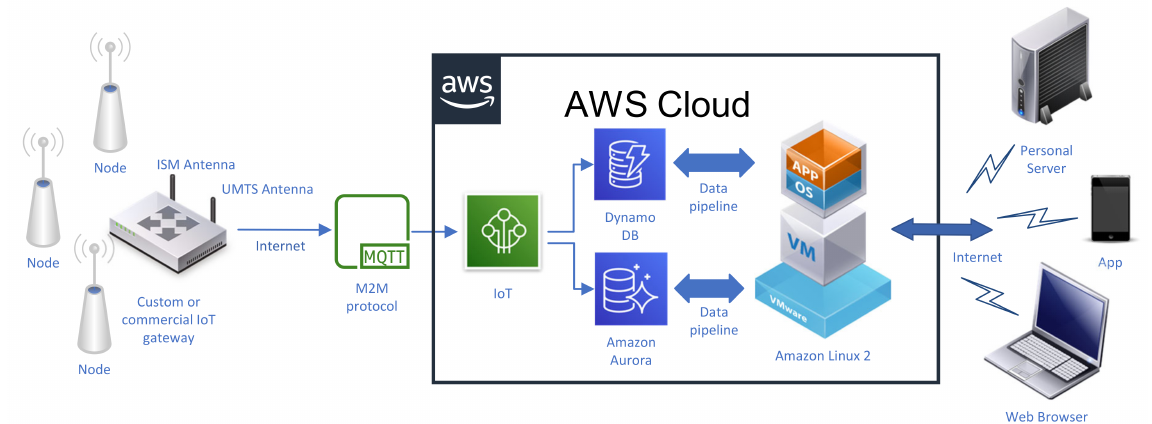
Figure 2. Scheme of the wireless microclimate monitoring system. With respect to the notation: IoT is Internet of Things, ISM is industrial, scientific, medical band, UTMS is Universal Mobile Telecommunications System, and AWS is Amazon Web